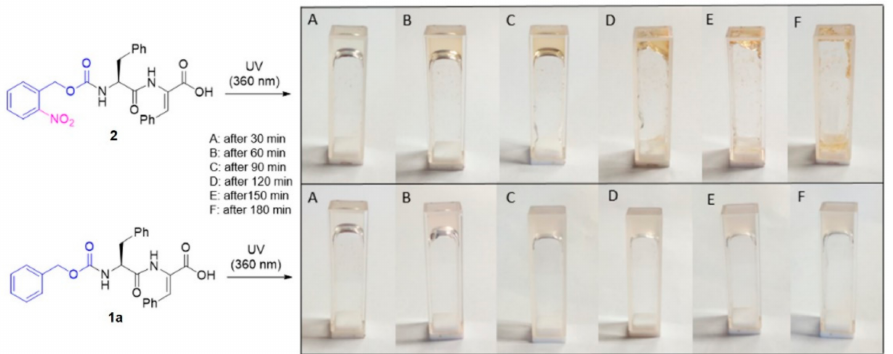
Figure 2. Inverted tube test of a 0.4 wt.% hydrogel of 2 (top panel) and 1a (bottom panel) after irradiation with UV light (360 nm) for 30 ( A ), 60 ( B ), 90 ( C ), 120 ( D ), 150 ( E ) and 180 ( F ) minutes— photographs taken 5 min after inversion.